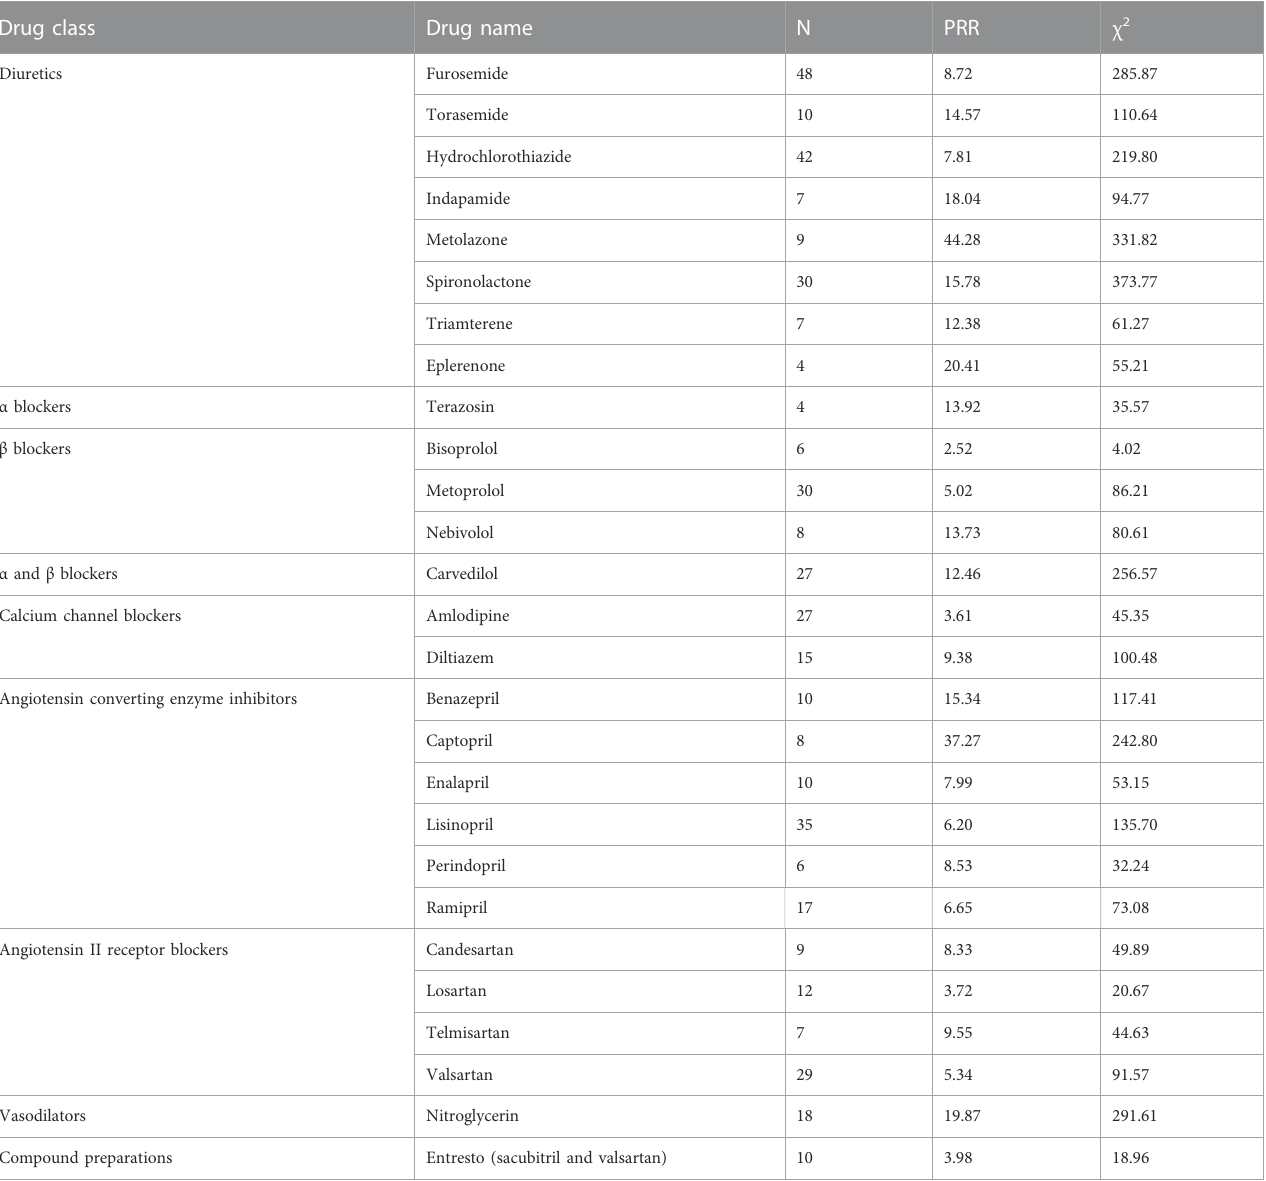
TABLE 4 Antihypertensive drugs with positive signals for gouty arthritis. Drug